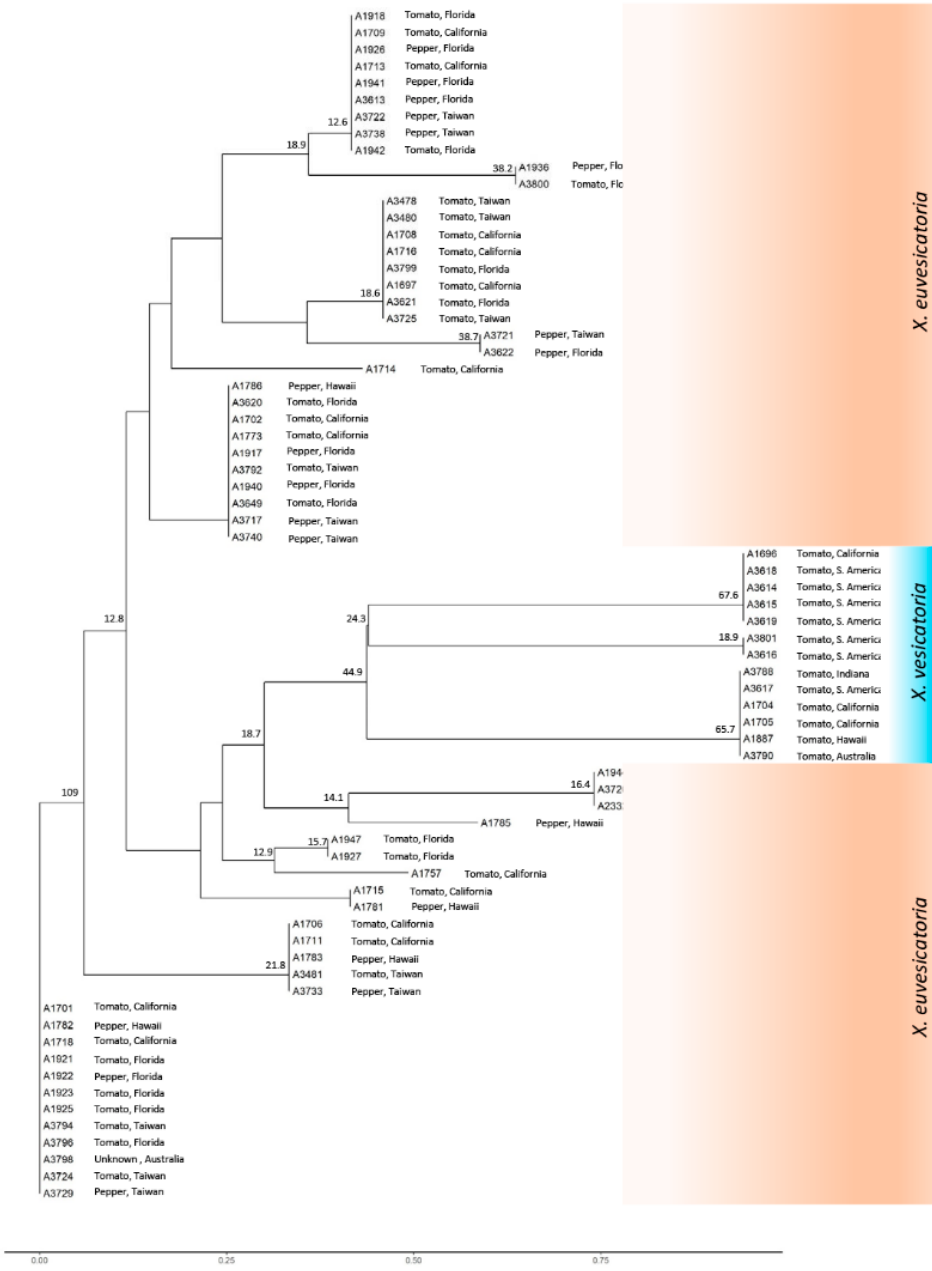
Figure 6. Phylogenetic tree for Xanthomonas euvesicatoria and X. vesicatoria , obtained using binary data for reactivity of these species with monoclonal antibodies Mab 1, Mab 3, Mab 5, Mab 7, Mab 8, and Mab 15. Bootstrap values shown on nodes are presented as the percentage of 1000 replicates. Line in the bottom represents the scale bar that shows the distance between the species.